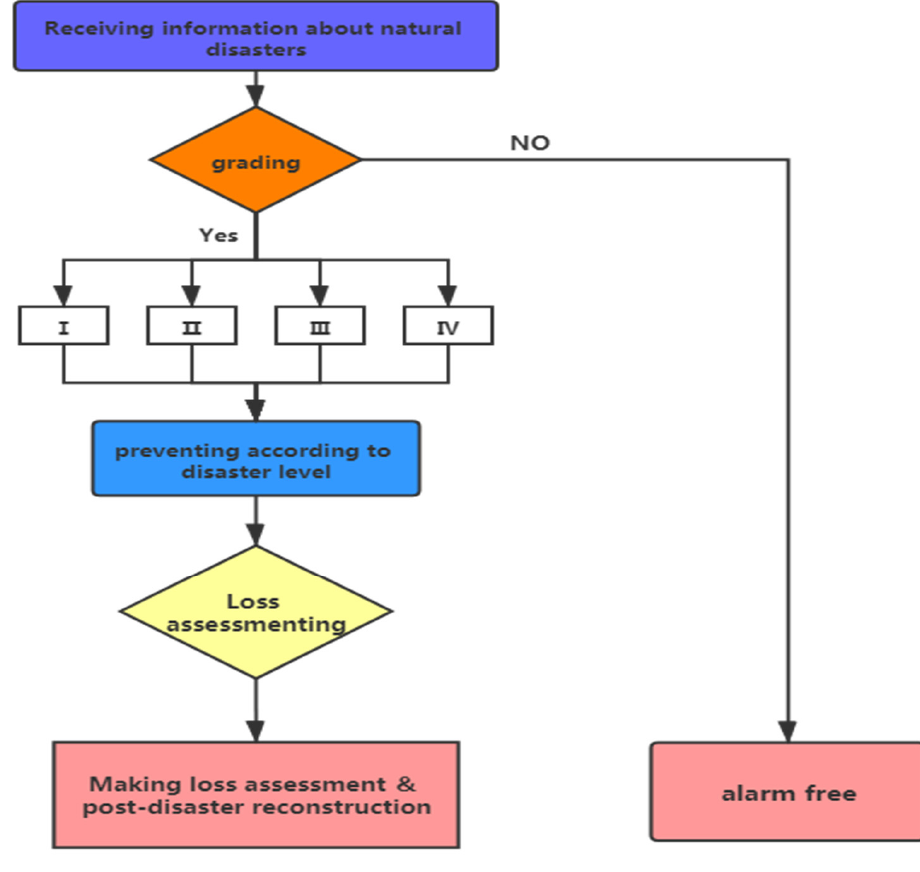
Figure 13. The flow of early warning.